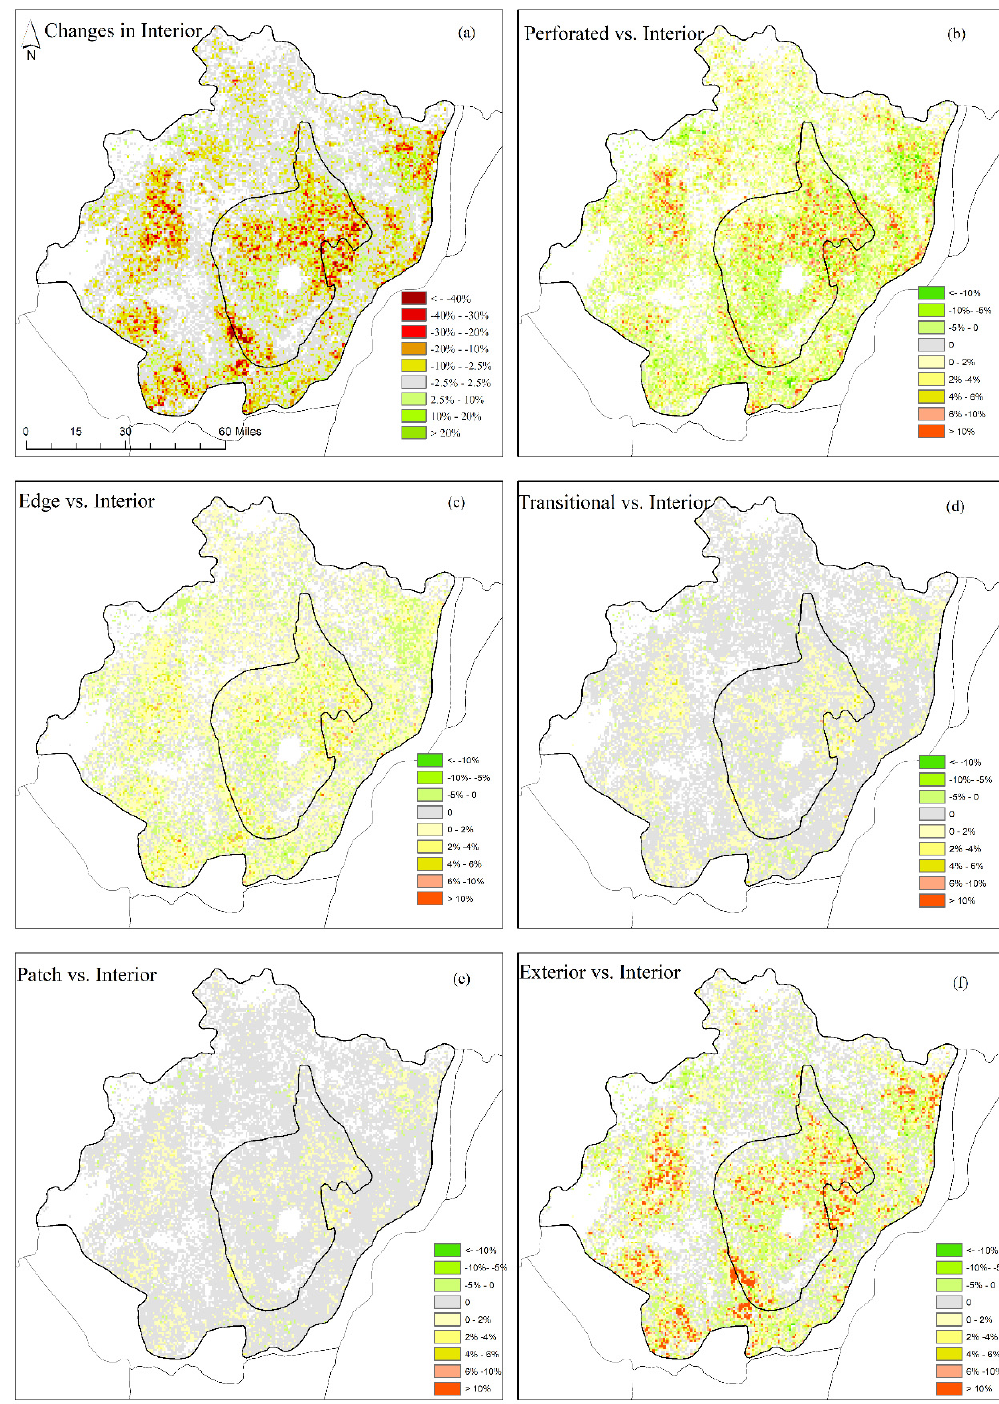
Figure 6. Spatial patterns in conversions between interior grassland and other fragmentation categories during 2008–2018: ( a ) changes in interior, ( b ) perforated vs. interior, ( c ) edge vs. interior, ( d ) transitional vs. interior, ( e ) patch vs. interior, and ( f ) exterior vs. interior. Grassland fragmentation patterns in the Bluegrass Region were also revealed by using several landscape metrics (Table 1, Table 3). Our results suggested that the percentage of landscape (PLAND)